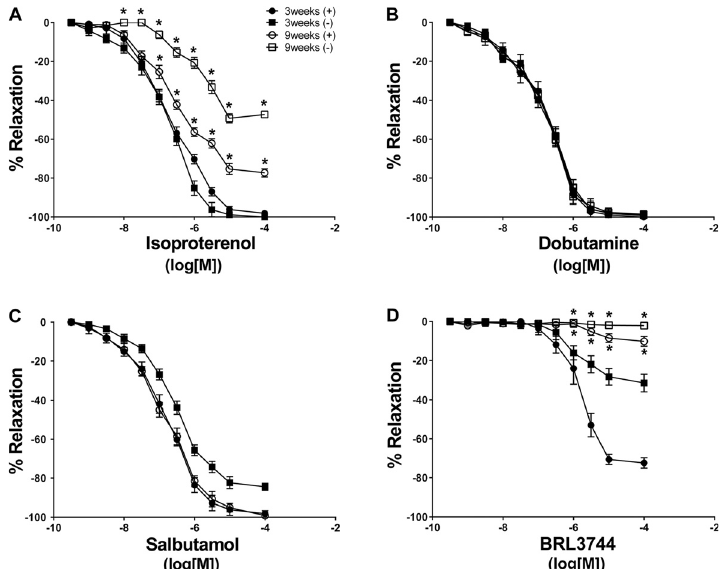
Table 2. pD2 values for b -adrenergic agonist-induced relaxation in aortic rings with ( + ) and without ( – ) endothelium.